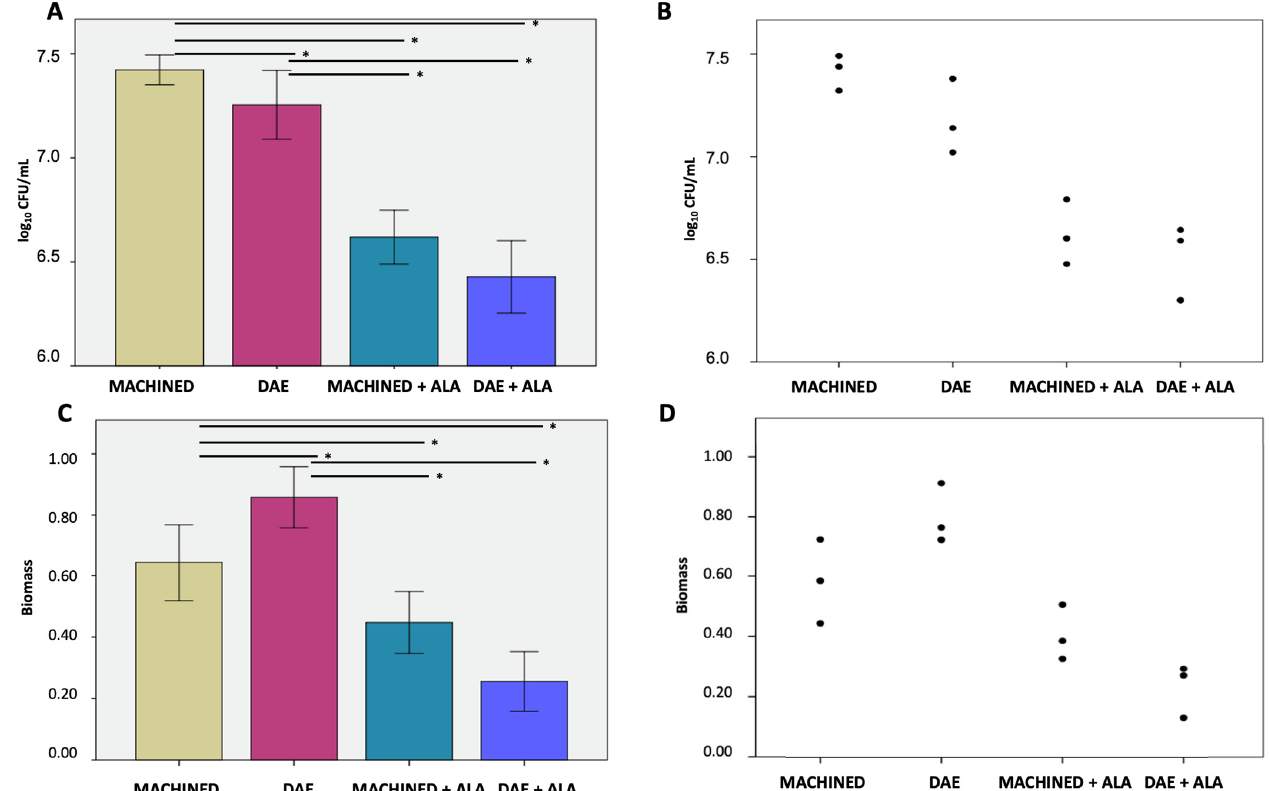
Figure 2. Colony ‐ forming units ( A ) and relative dot plot ( B ); biofilm biomass ( C ) and relative dot plot ( D ) of Streptococcus oralis biofilm grown for 24 h + 24 h on MACHINED and DAE surfaces with or without being exposed to ALAD–PDI. Negative controls showed no CFUs and no biofilm biomass (data not shown). * p ‐ value < 0.050.